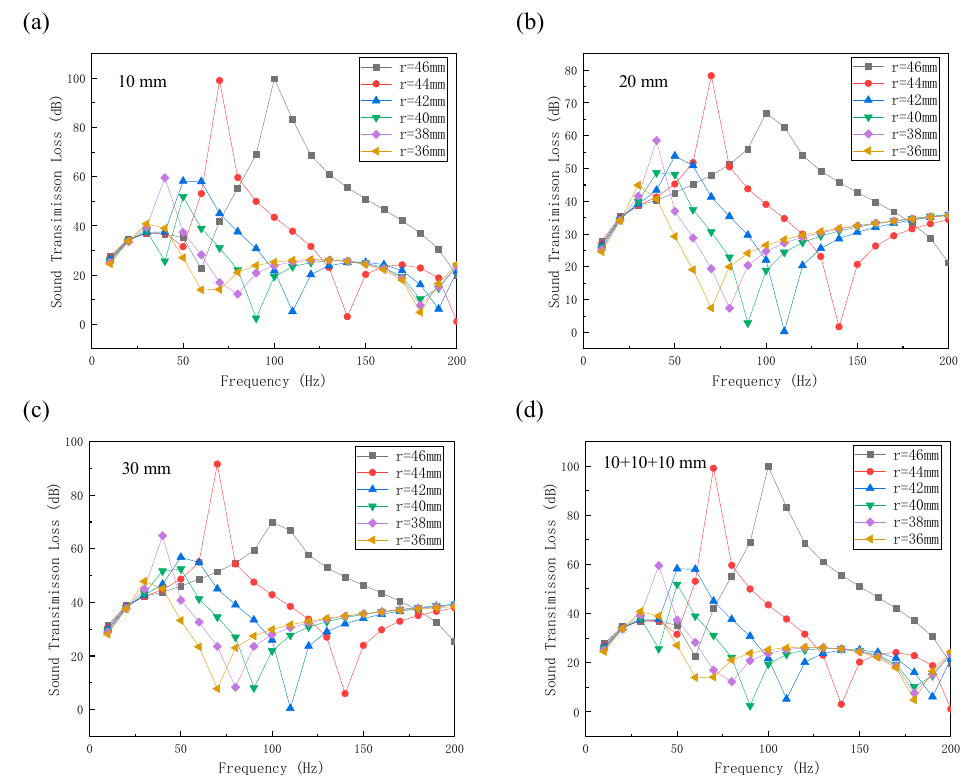
Figure 8. Effect of r on the local STL: ( a ) local STL of a 10 mm-thick phononic crystals plate, ( b ) local STL of a 20 mm-thick phononic crystals plate, ( c ) local STL of a 30 mm-thick phononic crystals plate, and ( d ) local STL of the phononic crystals cavity plates.